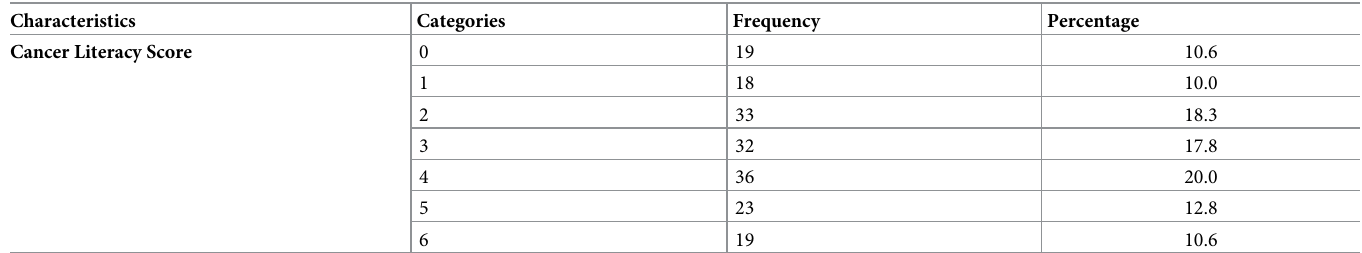
Table 3. Cancer literacy scores among the study participants (n = 180).